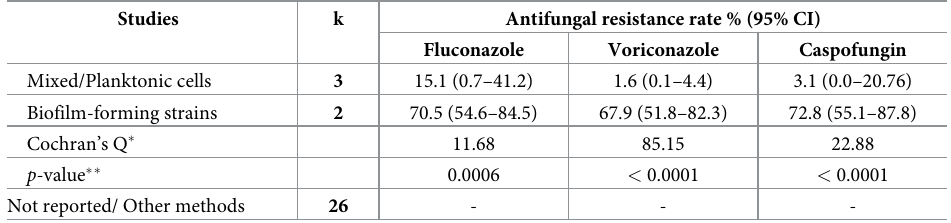
Table 7. Summary of subgroup analysis for antifungal resistance in Candida spp. isolates.